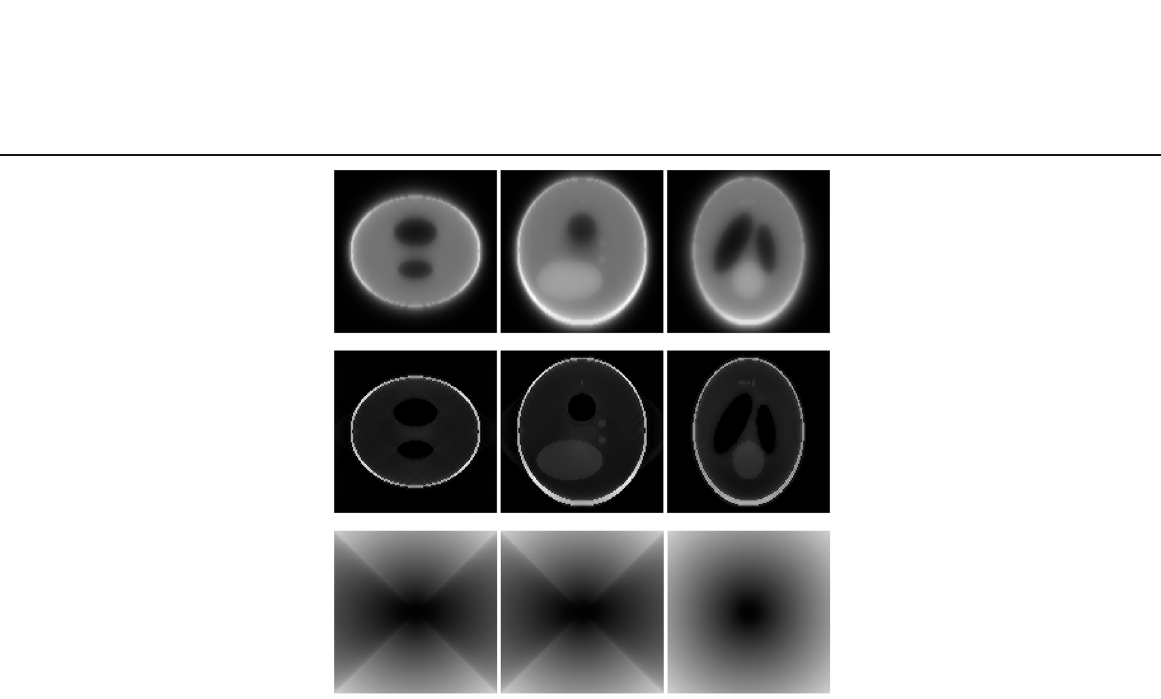
Fig. 7 Image reconstruction using proposed algorithm for the case of ψ = π /4 and σ = 10. Row 1 : TOF backprojection. Row 2 : Final reconstruction. Row 3 : Tomographic filter H . Three central orthogonal cuts are shown for each row